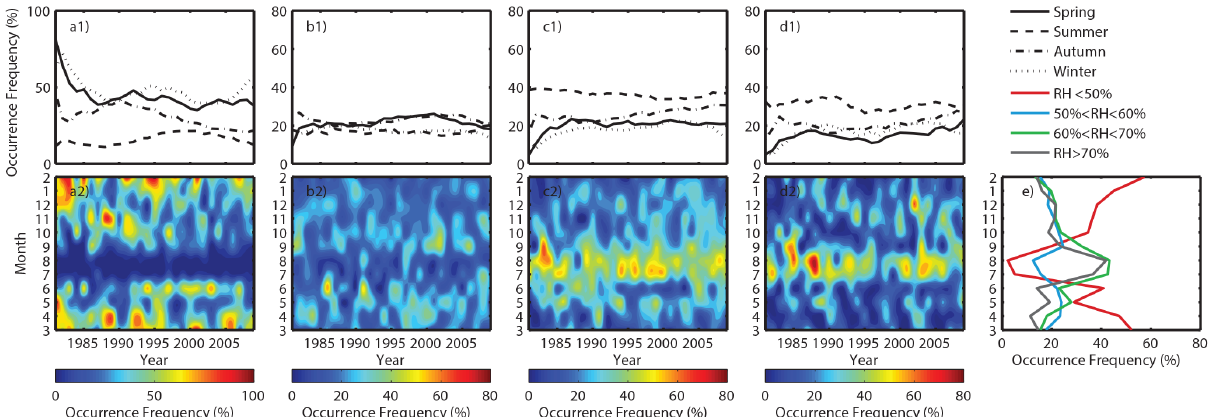
Figure 7. (1) The decadal trend of the 10-year moving average frequency of occurrence of 14h (LT) haze event RH in the range of (a) RH < 50%, (b) 50% < RH < 60%, (c) 60% < RH < 70% and (d) RH > 70% during spring (MAM), summer (JJA), autumn (SON) and winter (DJF). (2) The seasonal–decadal variation of the frequency of occurrence of 14h (LT) haze event RH in the range of (a) RH < 50%, (b) 50% < RH < 60%, (c) 60% < RH < 70% and (d) 70% < RH < 80% and (e) the seasonal variation of the average frequency of occurrence of 14h (LT) haze event RH in the range of (a) RH < 50%, (b) 50% < RH < 60%, (c) 60% < RH < 70% and (d) RH > 70% during the period